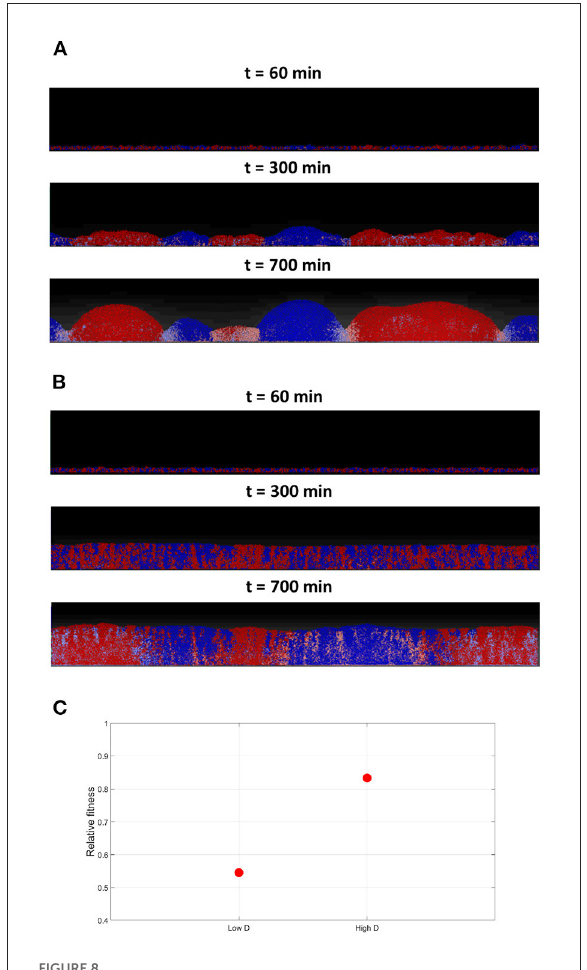
FIGURE8 (A) The competition between two toxin producing strains at low toxins diffusivities in a grid of 1,200 × 200 µ m . The low toxin diffusivity, increases its effectiveness, resulting in clusters with sharp, well-defined, boundaries. (B) Competition between two toxin producing strains, at high toxins diffusivities in a grid of 1,200 × 200 µ m , where D T is set to 10 times the nominal value. The high toxin diffusivity reduces its effectiveness as it gets more quickly diluted, resulting in a more uniform growth with less defined boundaries between the two spatially segregated strains. (C) The average fitness of the two strains engaging in mutual aggression, relative to their fitness in the no aggression scenario, under low and high